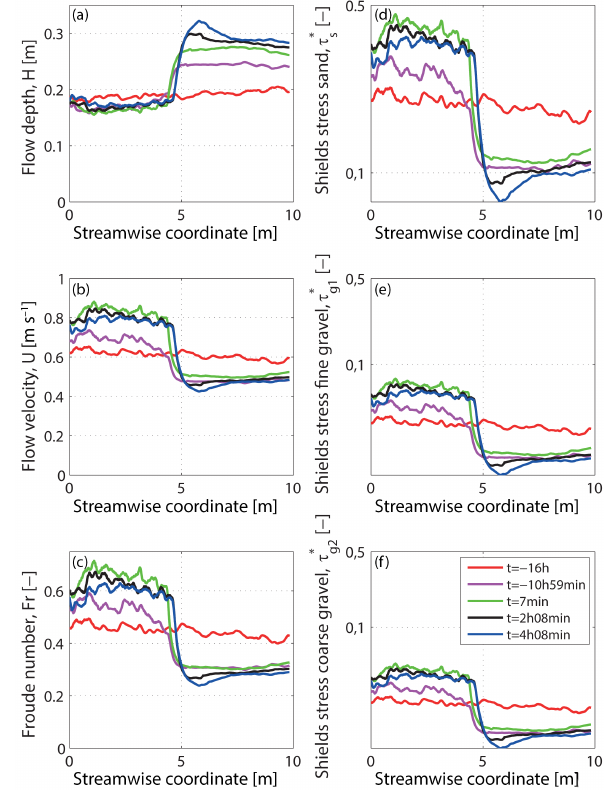
Figure 11. Hydraulic conditions of experiment T 1 and T 2 : (a) flow depth, (b) flow velocity, (c) Froude number, (d) Shields stress for the sand fraction (logarithmic scale), (e) Shields stress for the fine gravel fraction (logarithmic scale), and (f) Shields stress for the coarse gravel fraction (logarithmic scale). The Shields stress values were determined accounting for a sidewall correction due to Vanoni and Brooks (1957).